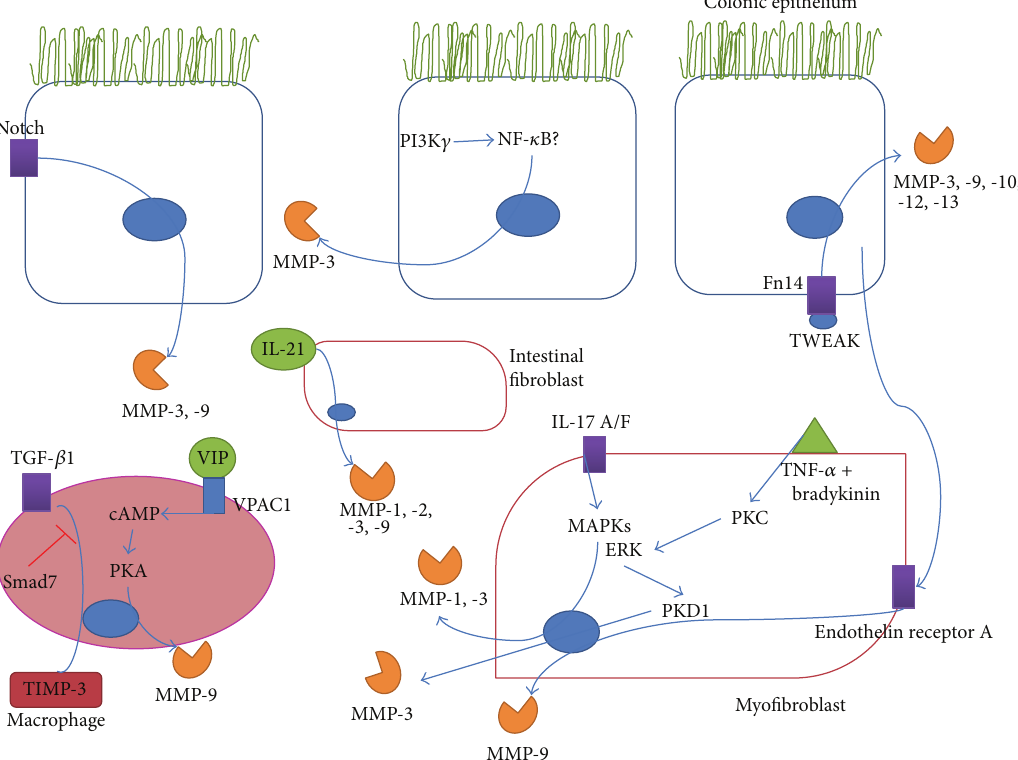
Figure 1: Recently described signalling pathways in the gut leading to the upregulation of MMPs in IBD or models of colitis. The various mediators whose interaction with receptors on colonic epithelial cells, intestinal fibroblasts, myofibroblasts, and macrophages can trigger signal transduction pathways leading to increased expression of MMPs or TIMPs are shown. PI3K 𝛾 (phosphatidylinositol-3 kinase 𝛾 ), NF- 𝜅 B (nuclear factor 𝜅 B), TWEAK (TNF-related weak inducer of apoptosis), TGF- 𝛽 (tissue growth factor 𝛽 ), cAMP (cyclic adenosine monophosphate), PKA (protein kinase A), VIP (vasoactive intestinal peptide), VPAC1 (vasoactive intestinal peptide receptor 1), MAPKs (mitogen activated protein kinases), ERK (extracellular signal-regulated kinase), PKC (protein kinase C), PKD (protein kinase D), and IL